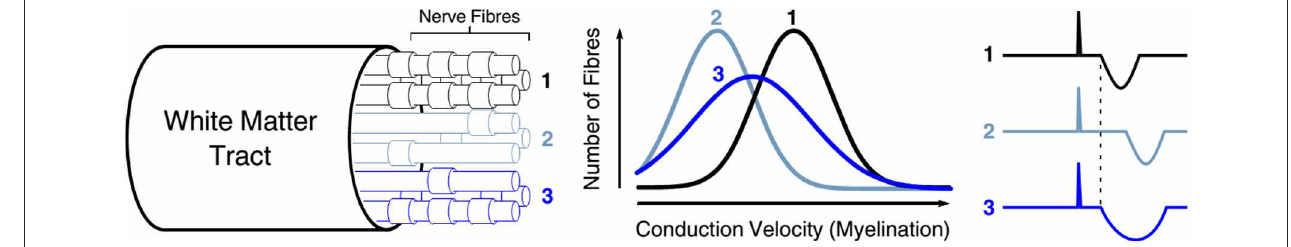
FIGURE 8 | Selective demyelination may play a role in prolonged iSP duration. When compared with (1) a healthy white matter tract, (2) uniformly demyelinated tracts in more advanced disease cause delayed iSP onset. However, (3) partially demyelinated tracts may lead to an increased iSP duration due to a wider distribution of conduction velocities among individual